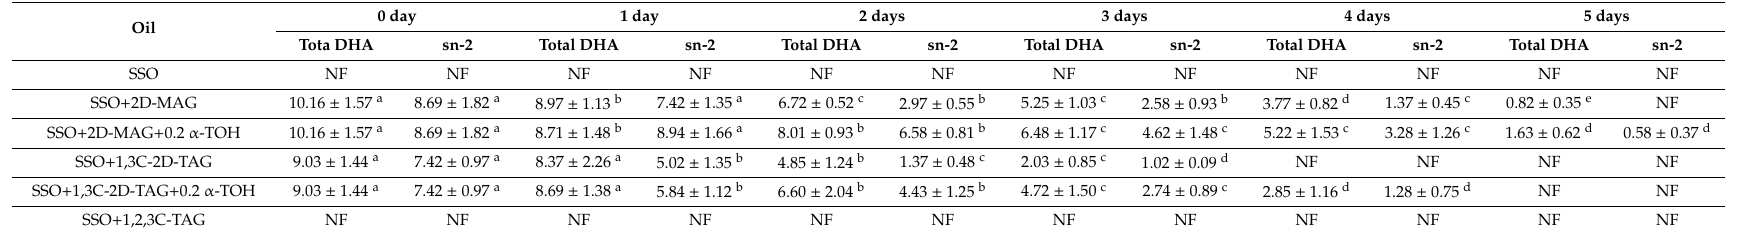
“NF” represents “Not Found”; “SSO” represents stripped soybean oil; “SSO + 2D-MAG” represents tripped soybean oil with monoglycerides (DHA at sn-2 position); “SSO + 2D-MAG + 0.2 α -TOH” represents stripped soybean oil with monoglycerides (DHA at sn-2 position) and α -tocopherol; “SSO + 1,3C-2D-TAG” represents stripped soybean oil with triglyceride (caprylic acid at sn-1,3 and DHA at sn-2 position); “SSO + 1,3C-2D-TAG + 0.2 α -TOH” represents stripped soybean oil with triglyceride (caprylic acid at sn-1,3 and DHA at sn-2 position) and α -tocopherol; “SSO + 1,2,3C-TAG” represents stripped soybean oil with caprylic triglyceride. Di ff erent superscripts lowercase letters in the same row indicate significant di ff erences ( p <